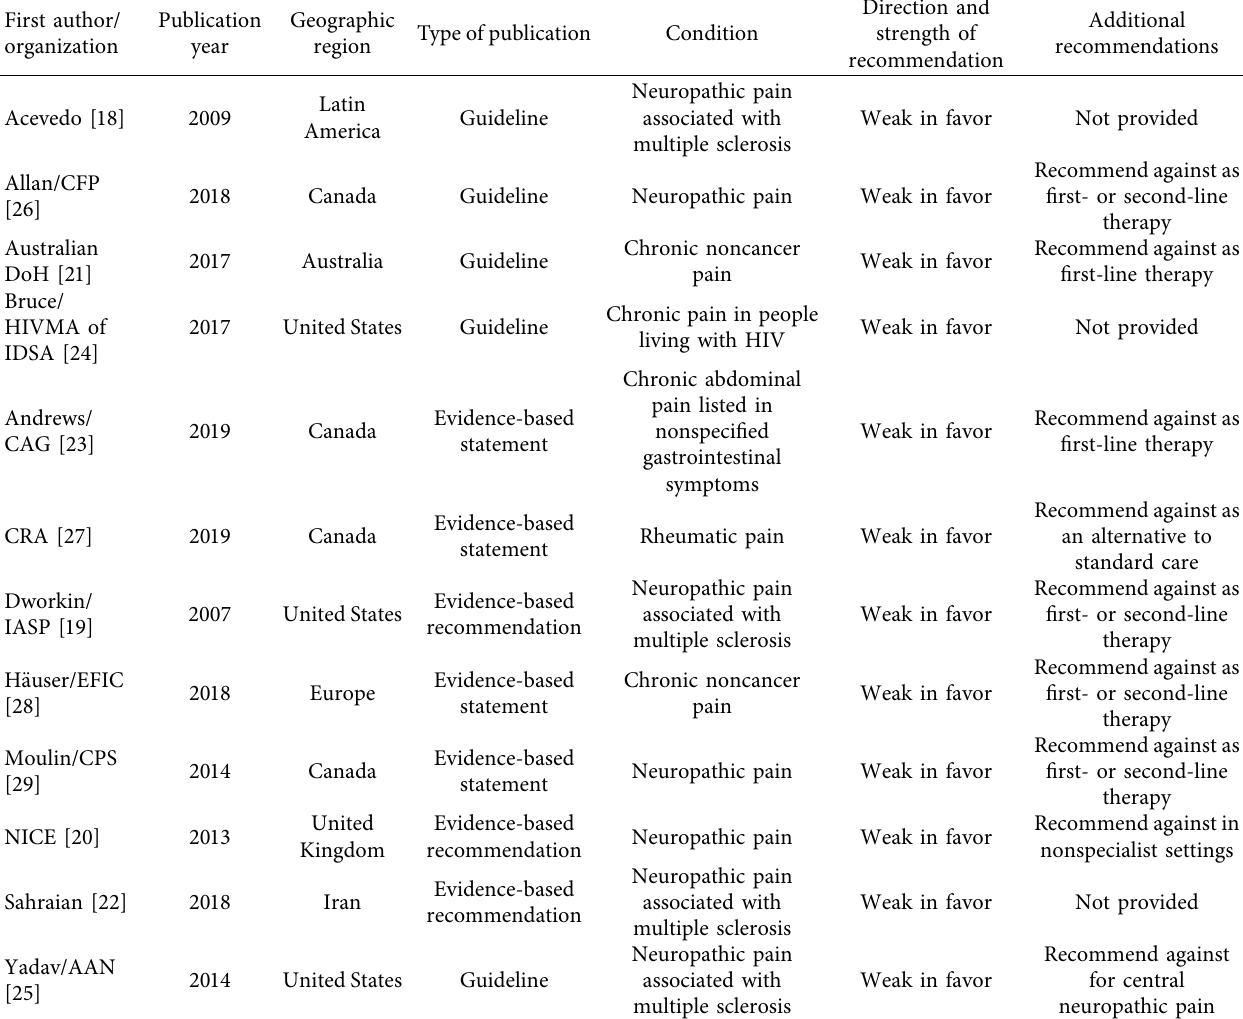
Table 1: Characteristics and summary of recommendations of medical cannabis for chronic pain management.